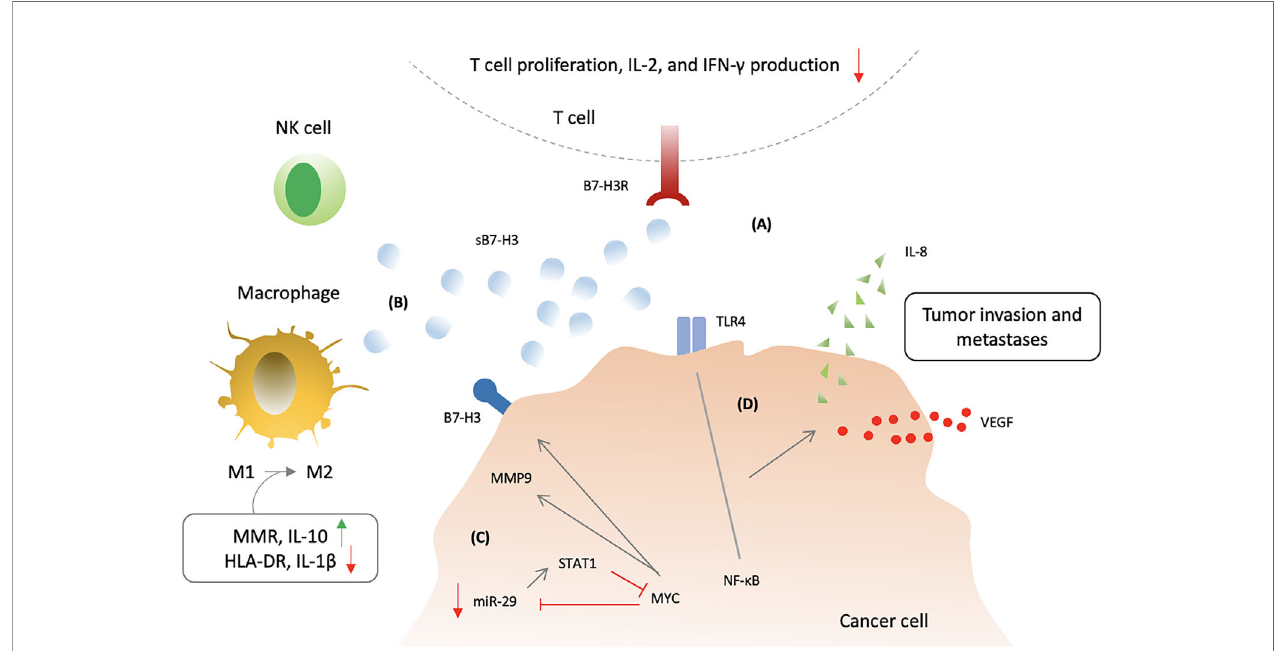
FIGURE 5 | Soluble B7-H3 biological activity and mechanism of action. (A) Soluble B7-H3 could disrupt B7-H3:B7-H3R interactions and inhibit T lymphocytes. (B) sB7-H3 supress NK cell-mediated tumor cell lysis and also switch macrophage phenotype from M1 (classically activated macrophage) to M2 (alternatively activated macrophage) via increasing expression of macrophage mannose receptor (MMR) and IL-10 and decreasing expression of HLA-DR and IL-1 b . (C) MYC and micR-29 may regulate the secretion of sB7-H3 via matrix metalloproteinases 9 (MMP9) as inhibtion of MYC or overexpression of micR-29 could increase the sB7-H3 and MMP9 expression. (D) Soluble B7-H3 may also induce cancer invasion and metastases through increased NF- k B activity via upregulating toll-like receptor 4 (TLR4) expression with consequent promotion of IL-8 and vascular endothelial growth factor (VEGF)